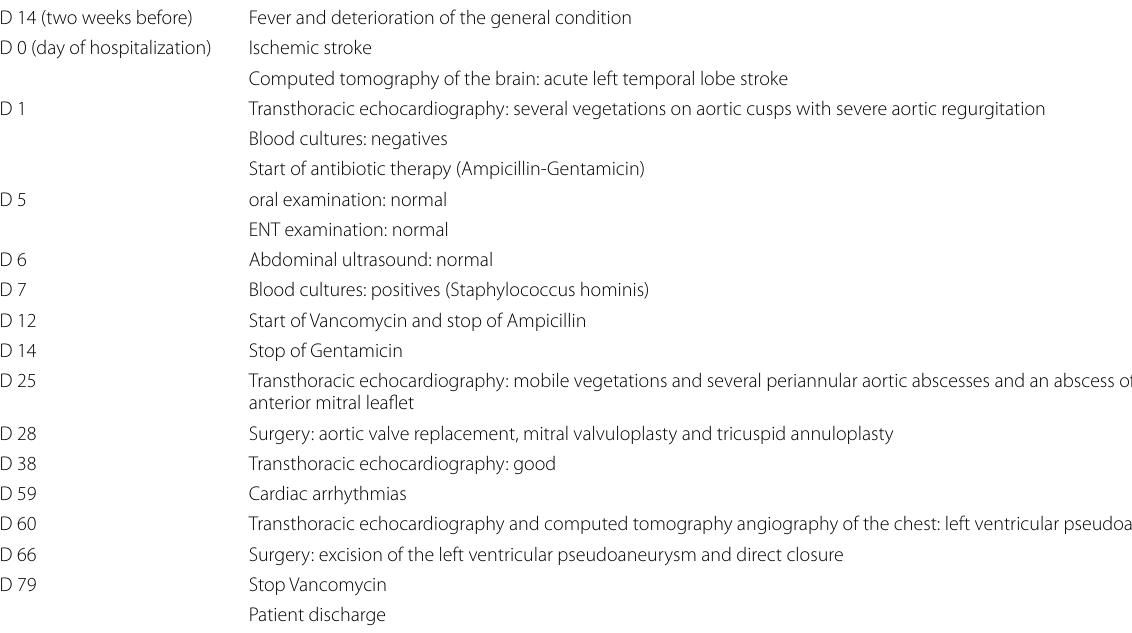
Table 1 Timeline of the patient’s